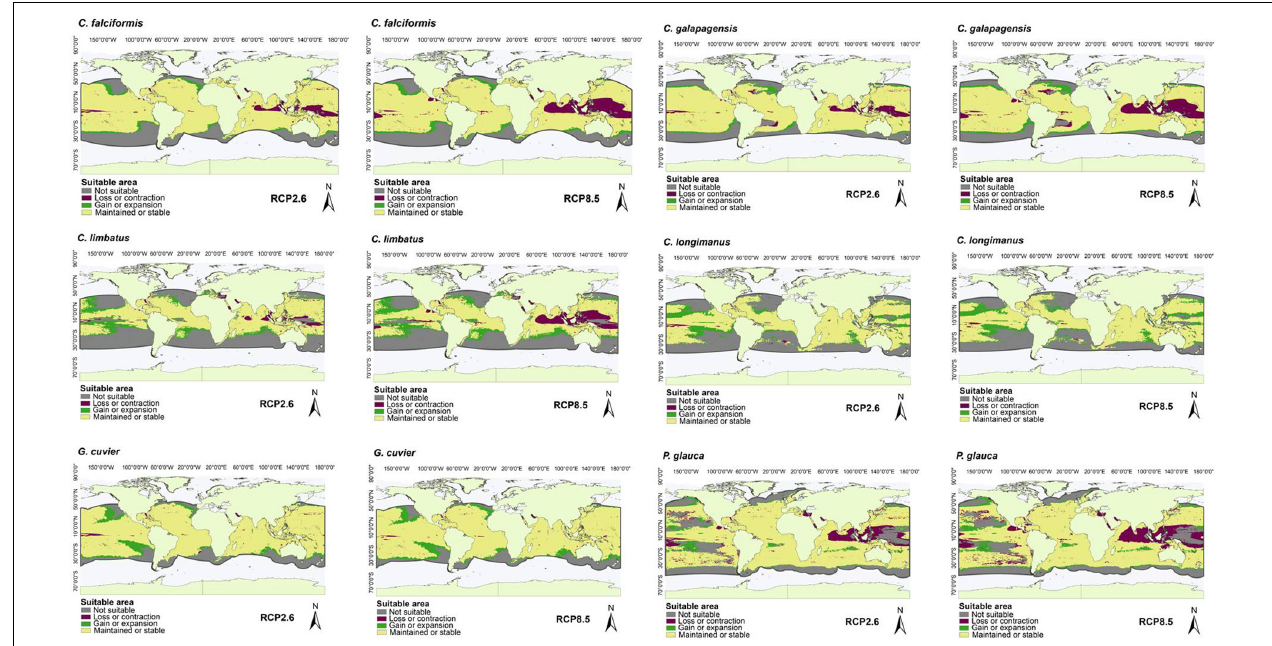
FIGURE 6 | Suitable areas maintained, gained, and lost by the year 2050 under low (RCP2.6) and high (RCP8.5) greenhouse gas emission scenarios with occurrence points outside of marine ecoregions and M areas in all regions of the oceans (Atlantic, Pacific, and Indian), including the Mediterranean Sea: C. falciformis, Carcharhinus galapagensis, C. limbatus, C. longimanus, G. cuvier, and P. glauca